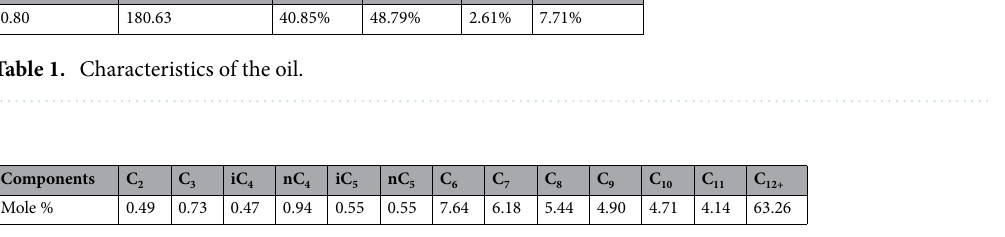
Table 2. Constituents of the crude